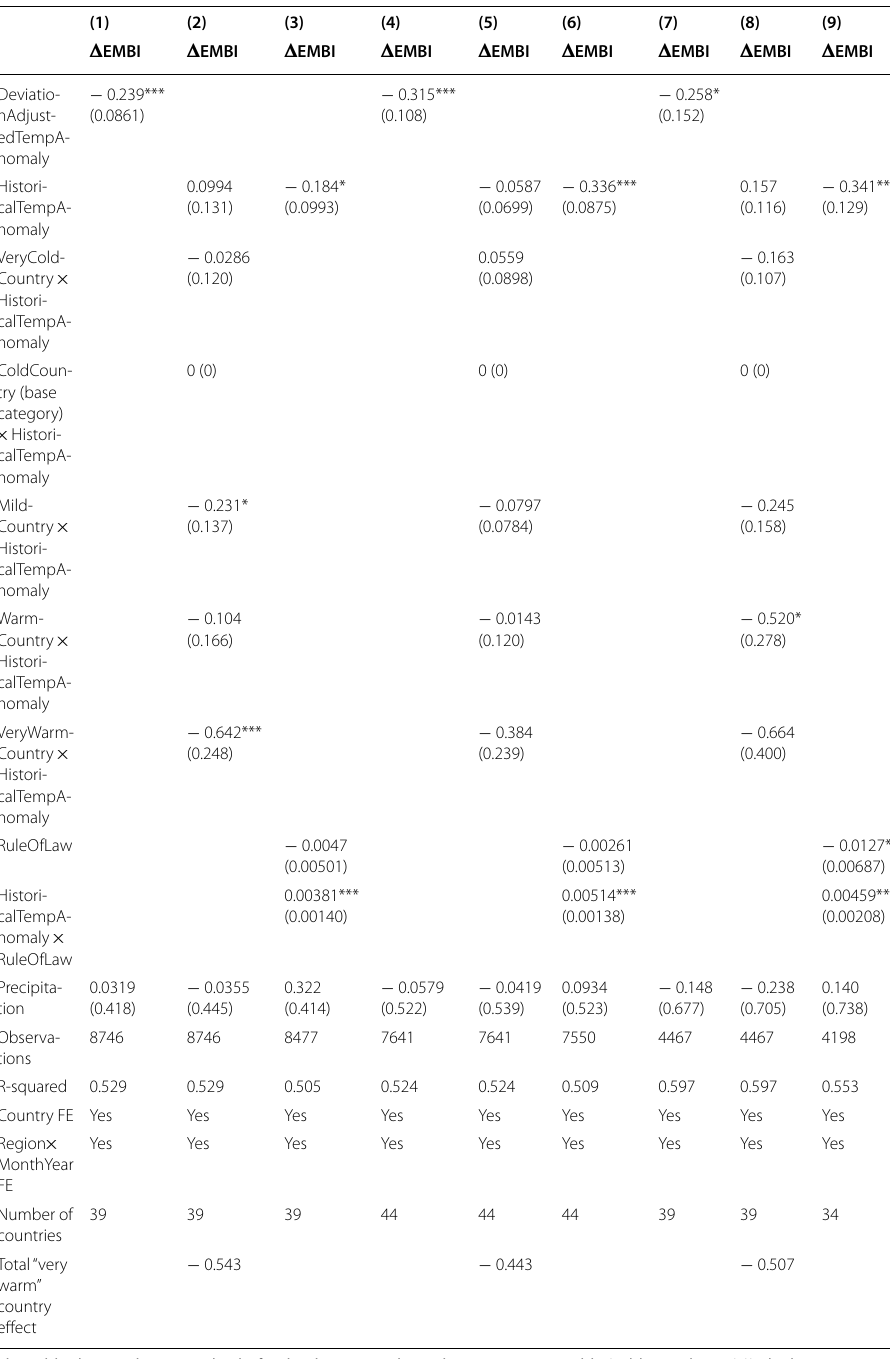
Table 14 Robustness tests: dropping countries with lower data coverage, larger landmass or political